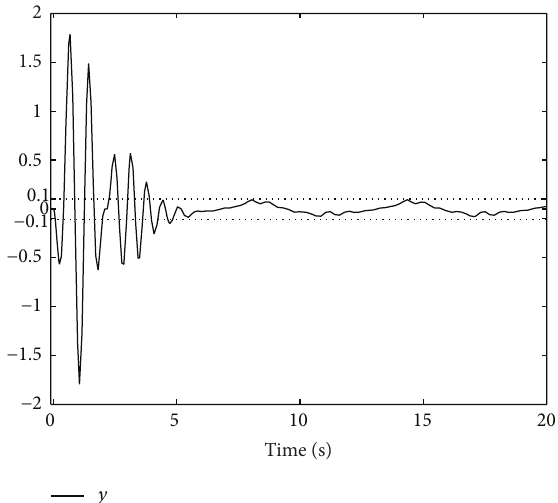
Figure 1: The trajectory of the tracking error 𝑦 .